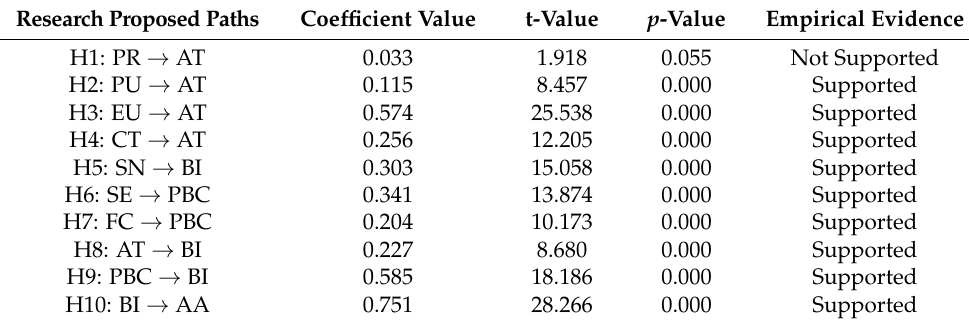
Table 7. Summary of proposed results for the theoretical model.